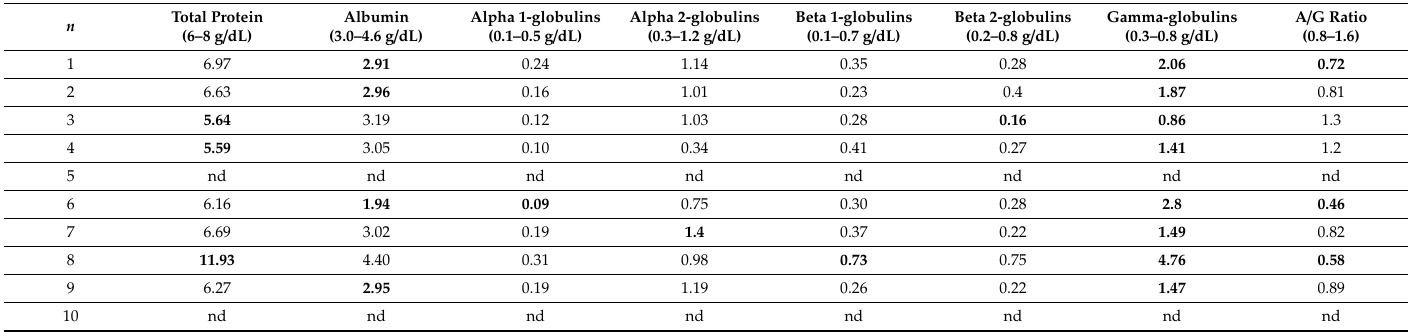
Table 6. Serum total protein, albumin and globulin content, and albumin to globulin ratio in L. infantum infected stray cats of Northern